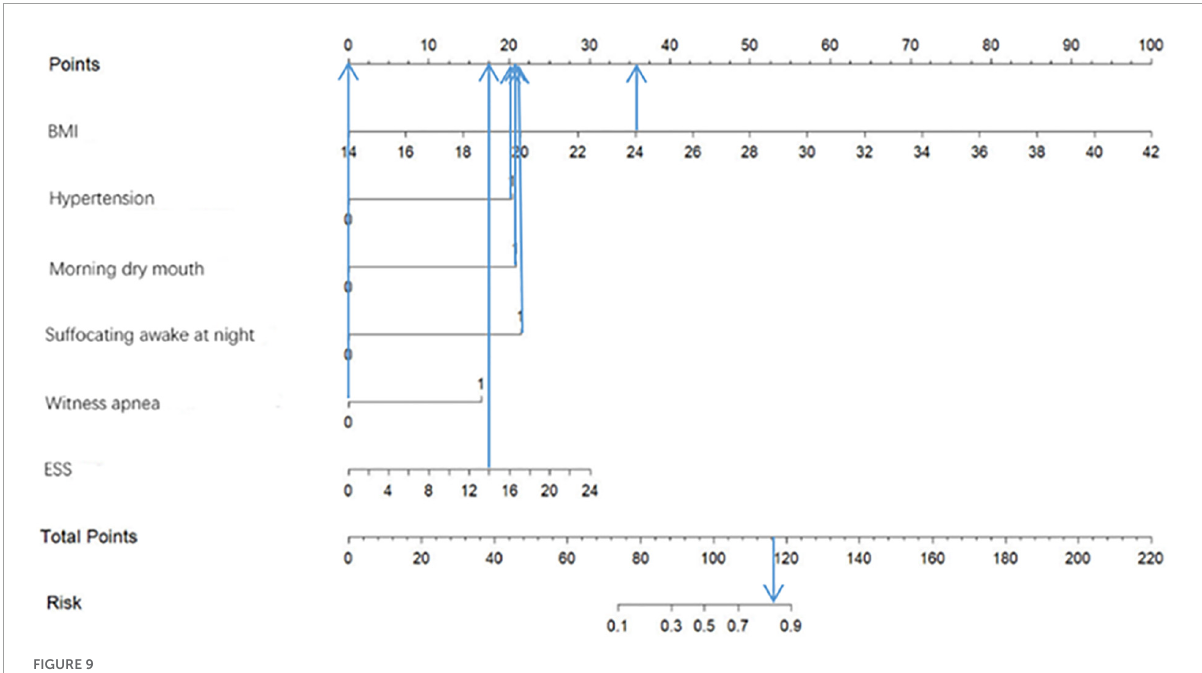
FIGURE9 Example of